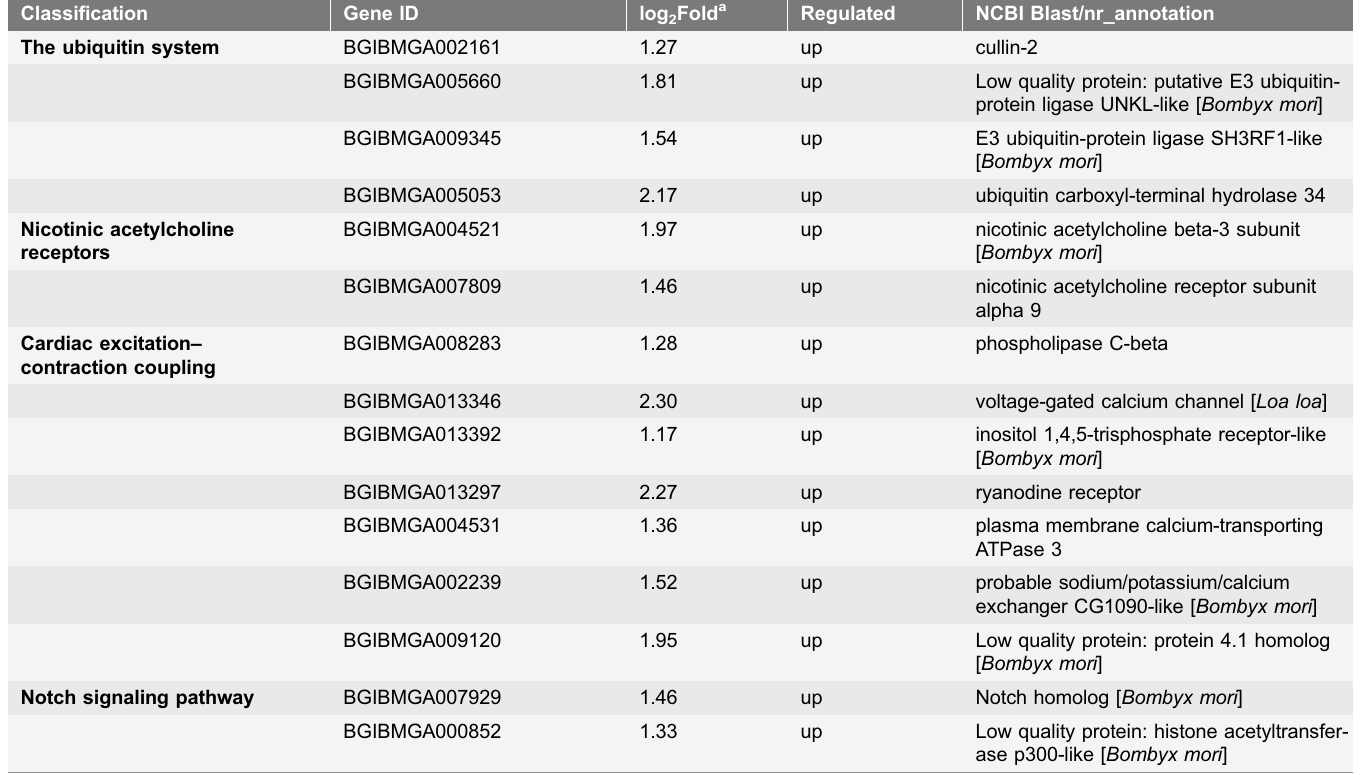
Table 3. Unique DEGs of interest in the cot mutant ( cot/cot ok / ok ) treated with hyperthermia. Classification Gene ID The ubiquitin